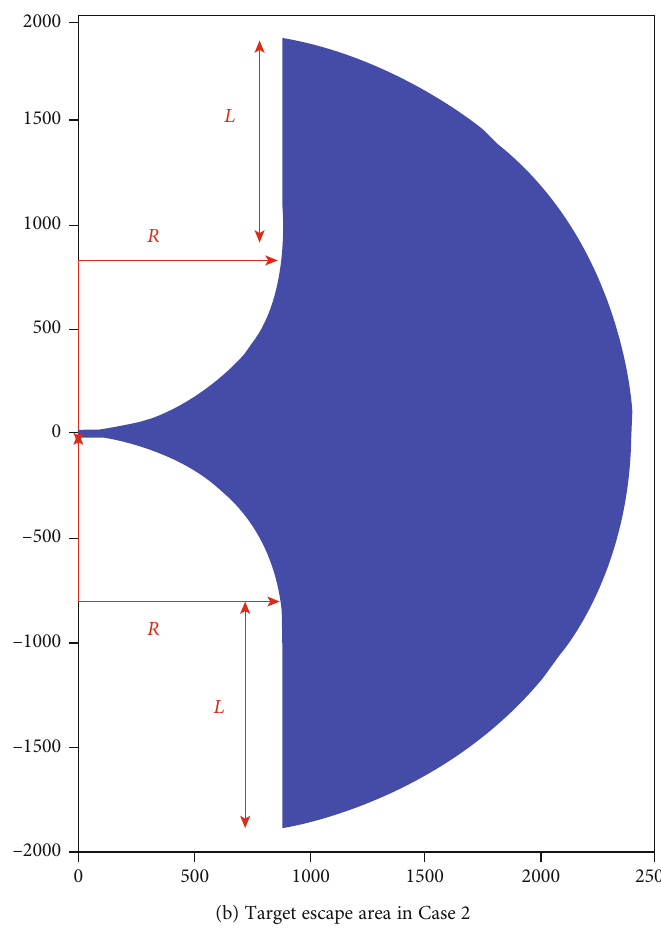
Figure 2: Target escape